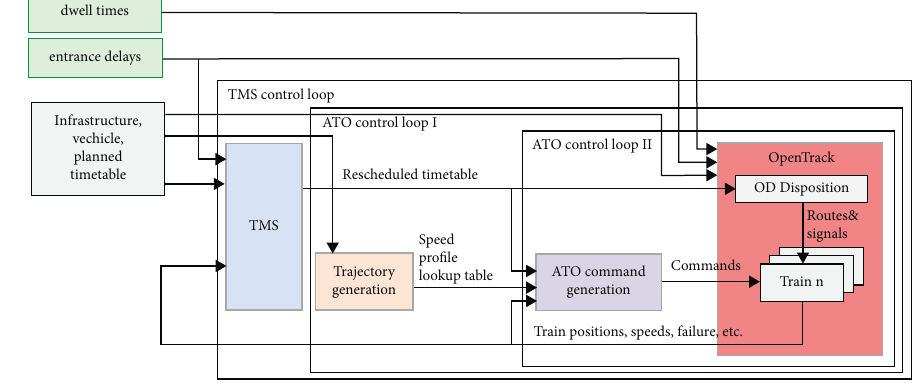
Figure 2: Simulation framework. Table 1: Inputs and